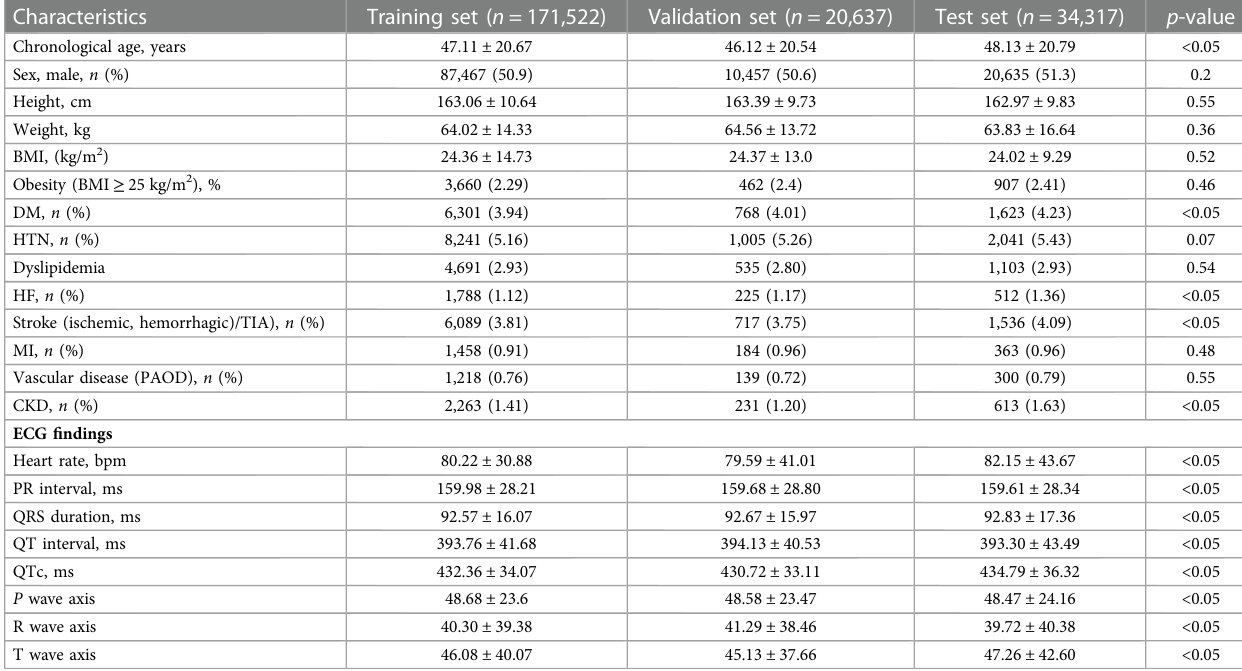
TABLE 1 Characteristics of the patients and electrocardiographic fi ndings in the training, validation, and test sets.